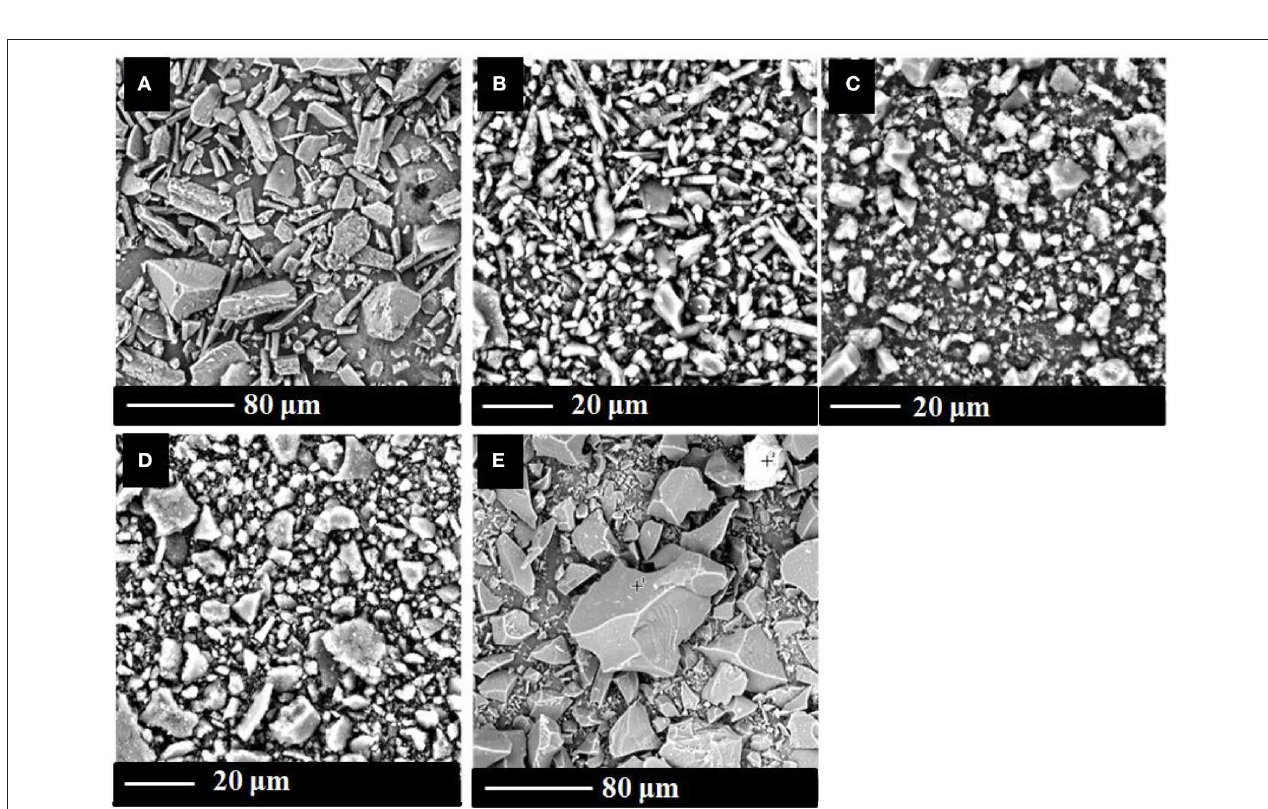
FIGURE 4 | SEM images of (A) ChF powder, (B) ChF biocarbon 300 ◦ C (powder), (C) ChF biocarbon 300 ◦ C (feathers), (D) ChF biocarbon 600 ◦ C (powder), and (E) ChF biocarbon 600 ◦ C